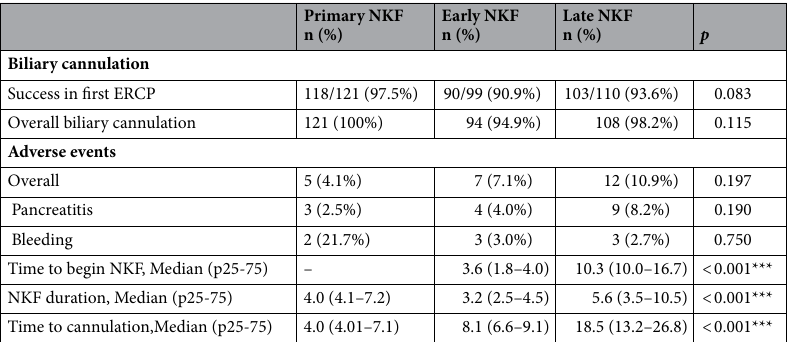
Table 2. Primary and secondary outcomes: cannulation rate, adverse events rate and length of time to create a fistula and time to achieve biliary cannulation in the 3 groups. p25-p75: lower and upper limit of the interquartile range. *** p <